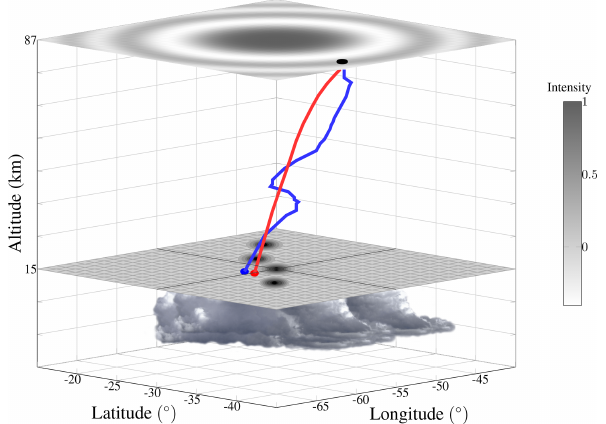
Figure 1. A 3D diagram showing a multi-step process of concentric gravity waves from the generation in the troposphere to the observa- tion in the mesosphere. The red and blue lines show the ray paths of zero and model winds respectively. Circular black patches represent overshooting